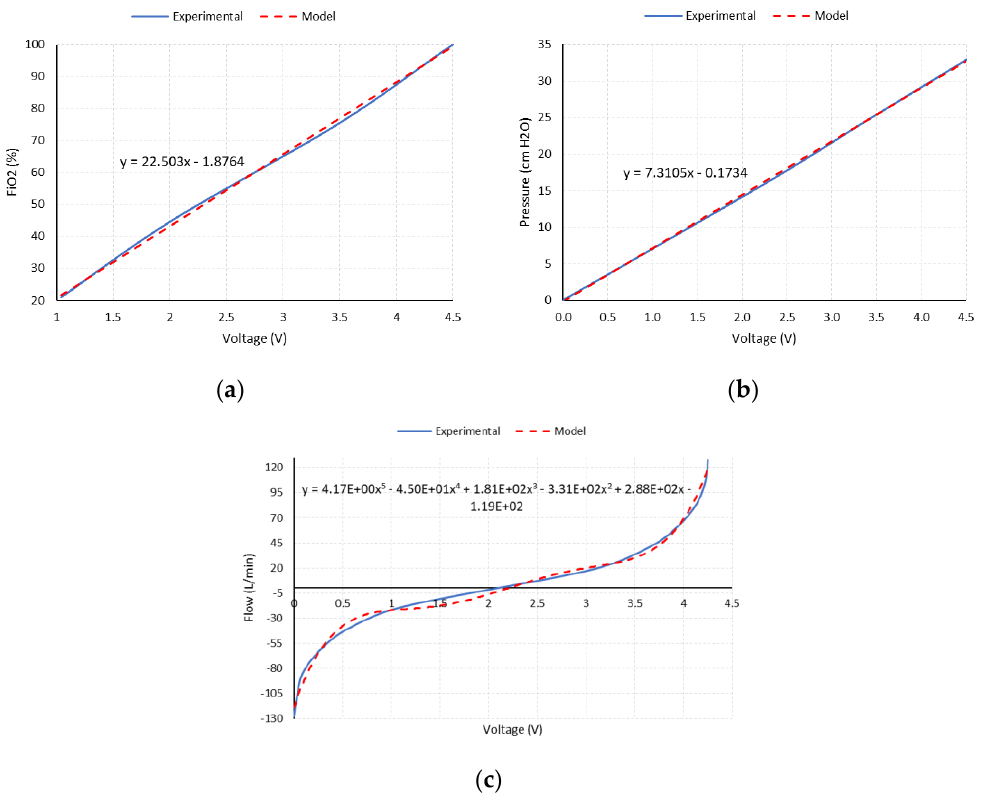
Figure 6. The amplified analog output of the sensors and model used. ( a ) Oxygen sensor; ( b ) pressure sensor; ( c ) airflow sensor.